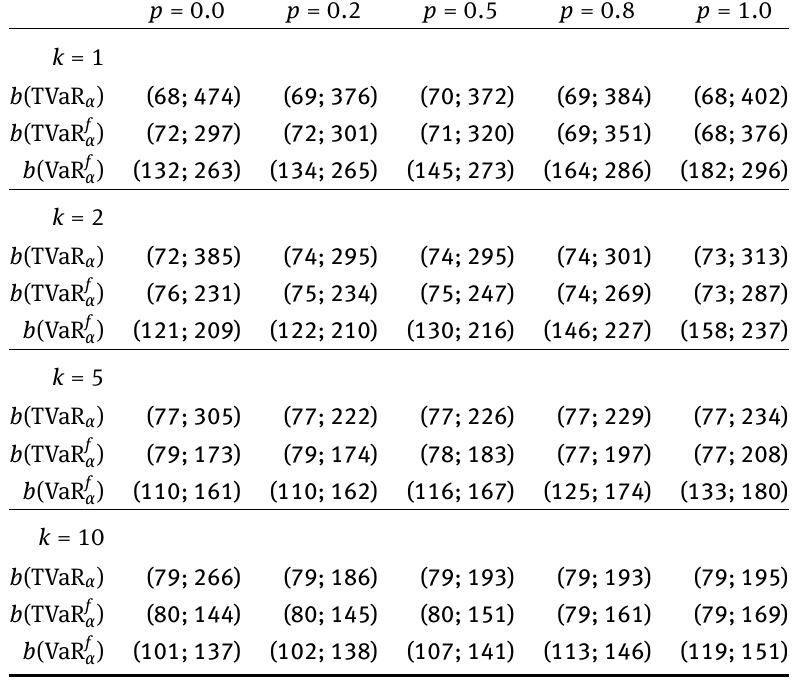
Table 4.2: VaR bounds with and without factor model information for various group sizes, d = 100 , α = 0.95 , k = 1, 2, 5, 10